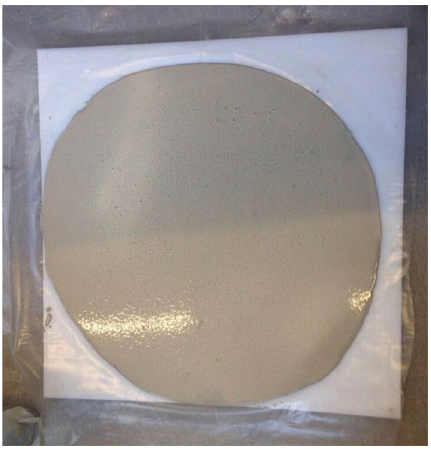
Fig. 5 Slump flow test of